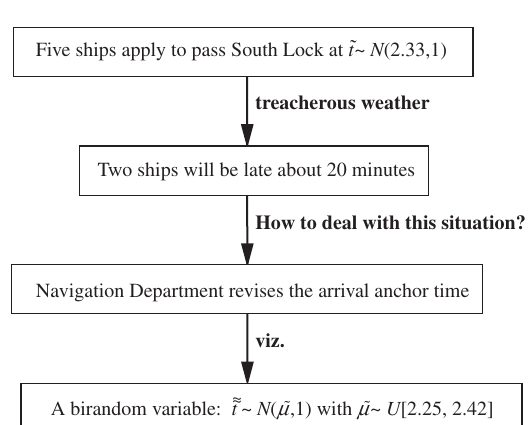
Fig. 4. Employing a birandom variable to express the arrival anchor